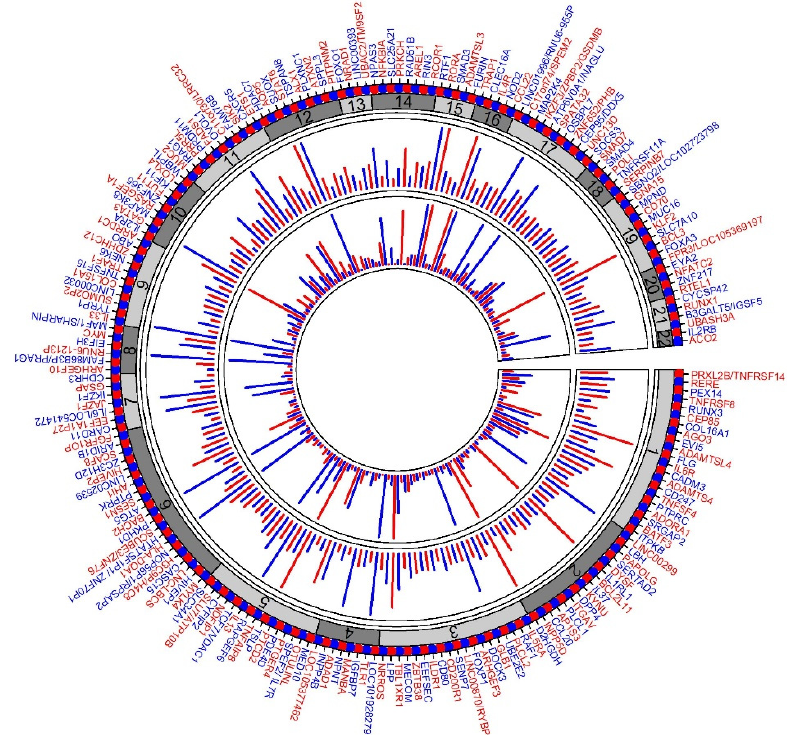
Figure 1. Circular plot of 212 asthma loci. Plot summarizing the 212 asthma loci described in Han et al. [35]. The first (outer) track shows the gene(s) representing the loci in alternating colors (red and blue). The second track with alternating shades of grays represents the chromosomes. The third track represents the association p -value from the UKBB + TAGC meta-analysis; each line represents − log10P of the strongest signal in the loci (for clarity, lines are truncated to ≤ 25). The innermost track represents the replication of each locus. Asthma GWAS loci with significance association p -value < 5 × 10 − 8 were accessed from the GWAS Catalog (https://www.ebi.ac.uk/gwas/home, accessed on 10 December 2021), and the number of hits for each loci was counted. All replications of 17q12-21 were merged to a single locus. The lengths of the lines show the number of hits (for clarity, lines are truncated for lengths up to 20).